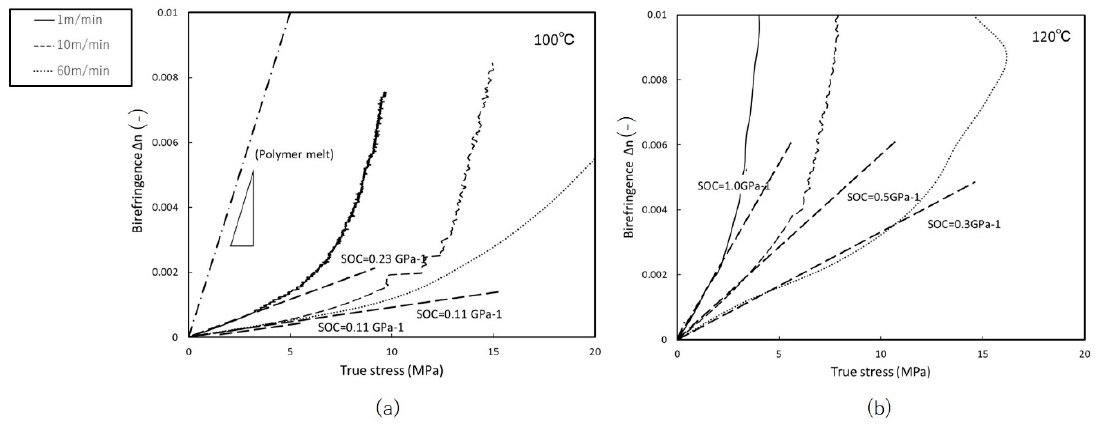
Figure 5. Birefringence vs. true stress of uniaxial free-width stretching at: ( a ) 100 °C ( b ) 120 °C.